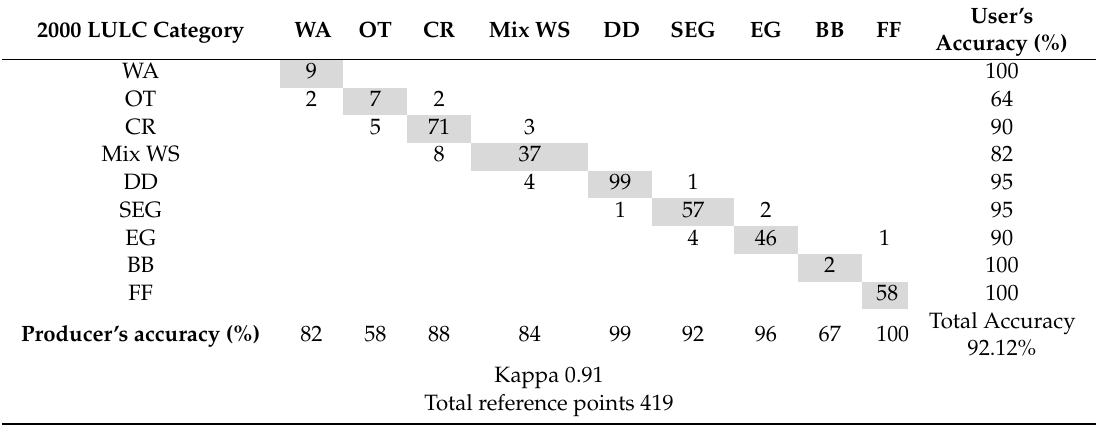
Table A3. Results of the accuracy assessment of the PBTC land cover map for 2000.